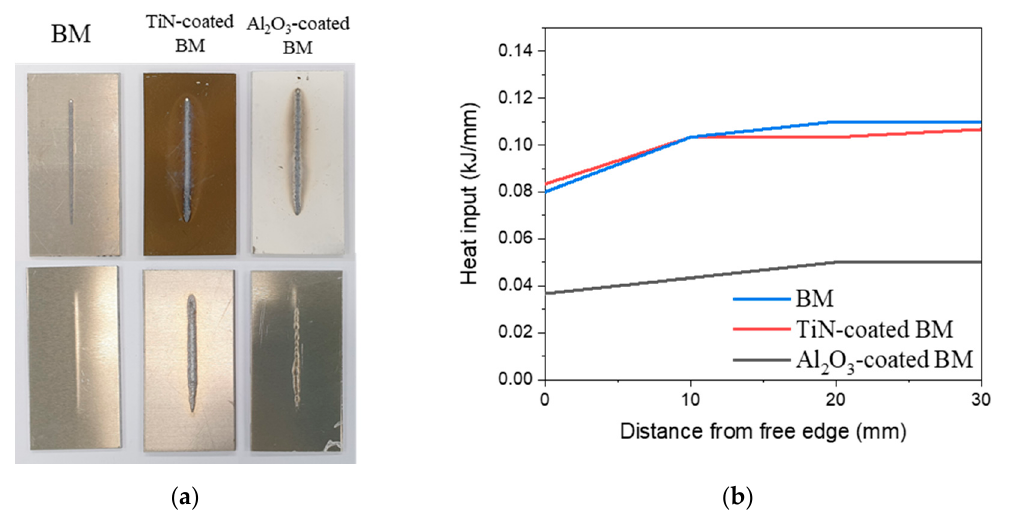
Figure 3. ( a ) Appearance of laser-welded samples using 10 mm/s of scan speed and 1 kW of laser power. The top and bottom images indicate the front bead and the back bead, respectively. ( b ) Free-edge test result showing the effect of coating materials.